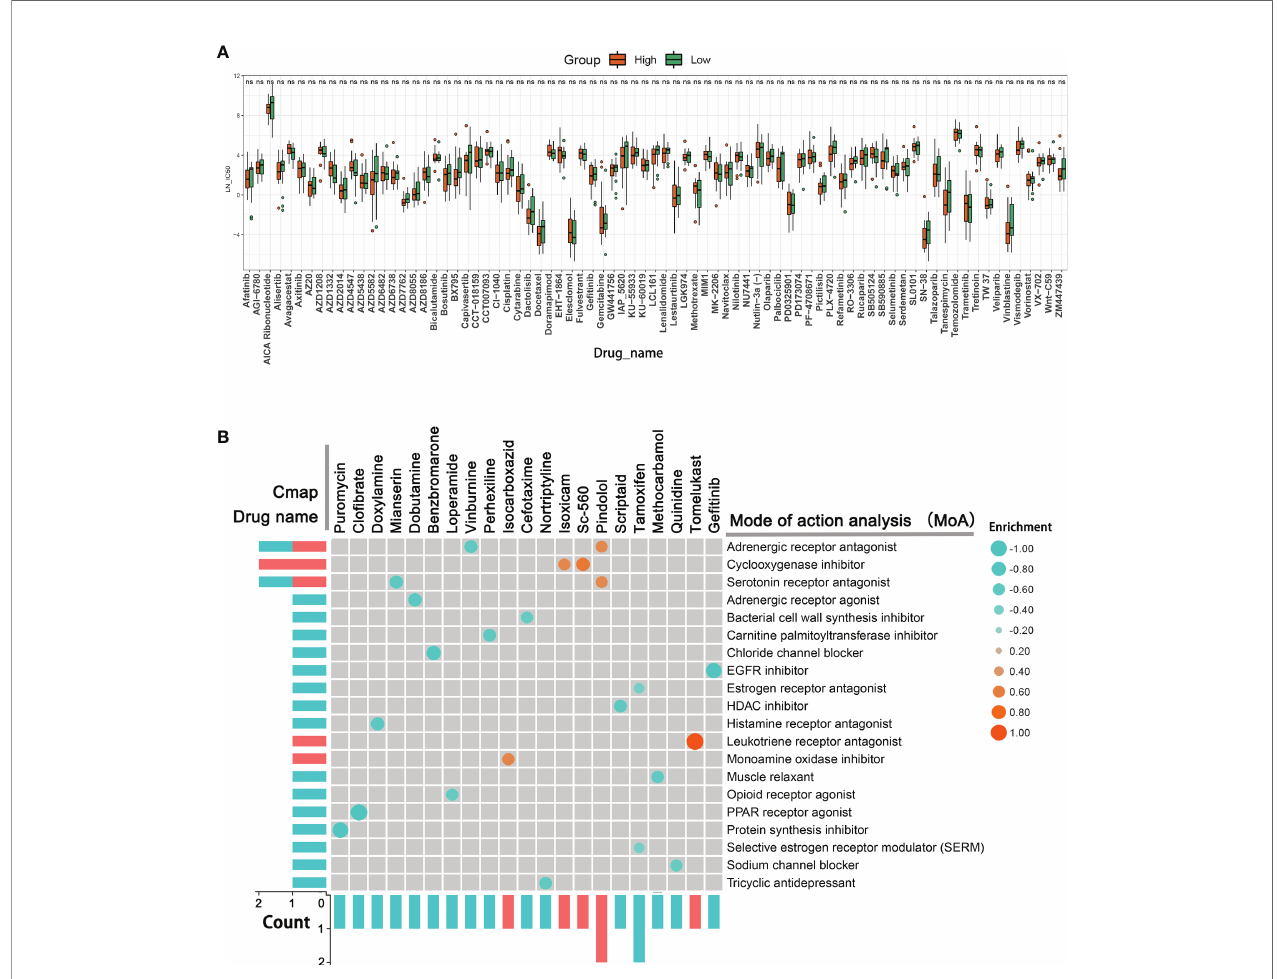
FIGURE 9 | New therapeutic regimens for OC. (A) The IC50 differences for 79 drugs between high- and low-TIMErisk clusters in TCGA database. (B) Novel candidate drugs targeting the TIME-related signature identi fi ed by CMap database